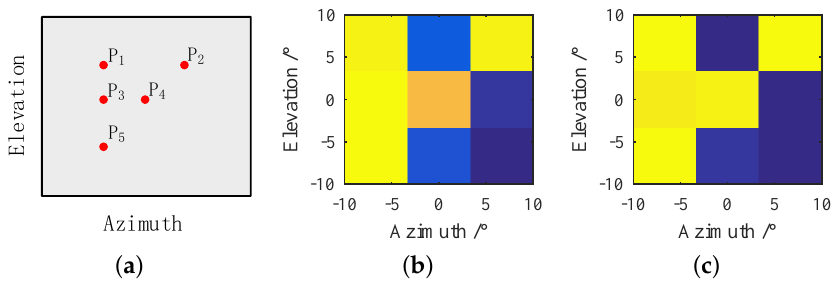
Figure 10. Azimuth-elevation image reconstruction results. Ground truth ( a ). Image reconstruction results with phase gradient L = 1 ( b ), and L = 2.5 ( c ).